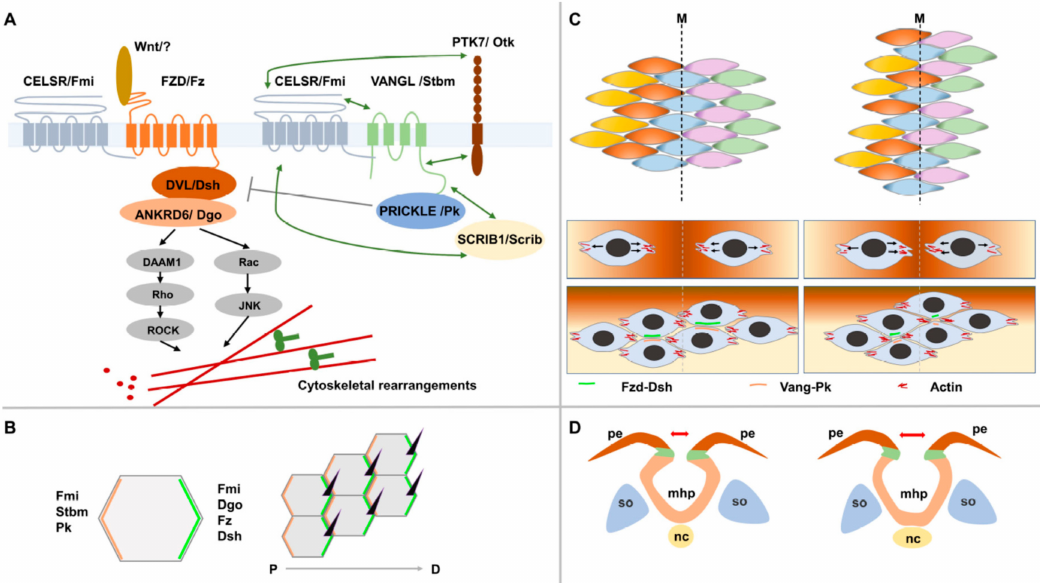
Figure 2. The non-canonical Wnt / planar cell polarity signaling pathway (PCP). ( A ) A simplified diagram of the PCP signaling pathway showing its core components, its downstream e ff ectors and two of its mediators Ptk7 / Otk and Scribble1 / Scrib. Nomenclature for core proteins is indicated in vertebrates and Drosophila (separated by / ). Genetic interactions are indicated by double arrows. ( B ) An example of a PCP-regulated process in the wing blade of Drosophila. Asymmetric localization of PCP protein complexes at the proximal (Vang-Pk) and distal (Fz-Dsh) sides of adjacent cells mediates the distal positioning and orientation of a single trichome in each cell of the wing epithelium. ( C ) The process of convergent extension. Cells elongate mediolaterally, move and intercalate with neighboring cells resulting in convergence toward the midline and extension along the anteroposterior axis. During this process, PK and VANGL localize anteriorly whereas FZD and DVL localize posteriorly. ( D ) A simplified diagram showing a widened neural plate because of a defective convergent extension (CE) of midline neuroepithelial cells. The neural folds will be far apart and will fail to fuse leading to a neural tube